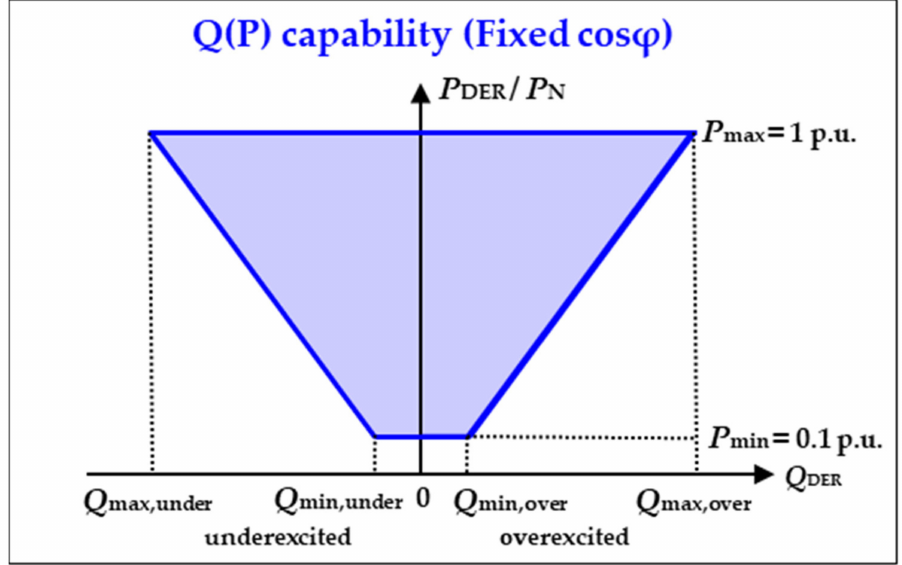
Figure 4. The assumed Q(P) provision capabilities of DERs in this study. After the new Q setpoint is determined, the local DER controller then checks the cal- culated setpoint according to a so-called extended Q(V) limitation characteristic (Figure 5) and limits the operating point of DER within the predefined operational area if the new Q setpoint lies outside this area. The applied Q(V) characteristic defines the operational area that can be used for reactive power management, depending on the local grid voltage at the point of common coupling (PCC) of the